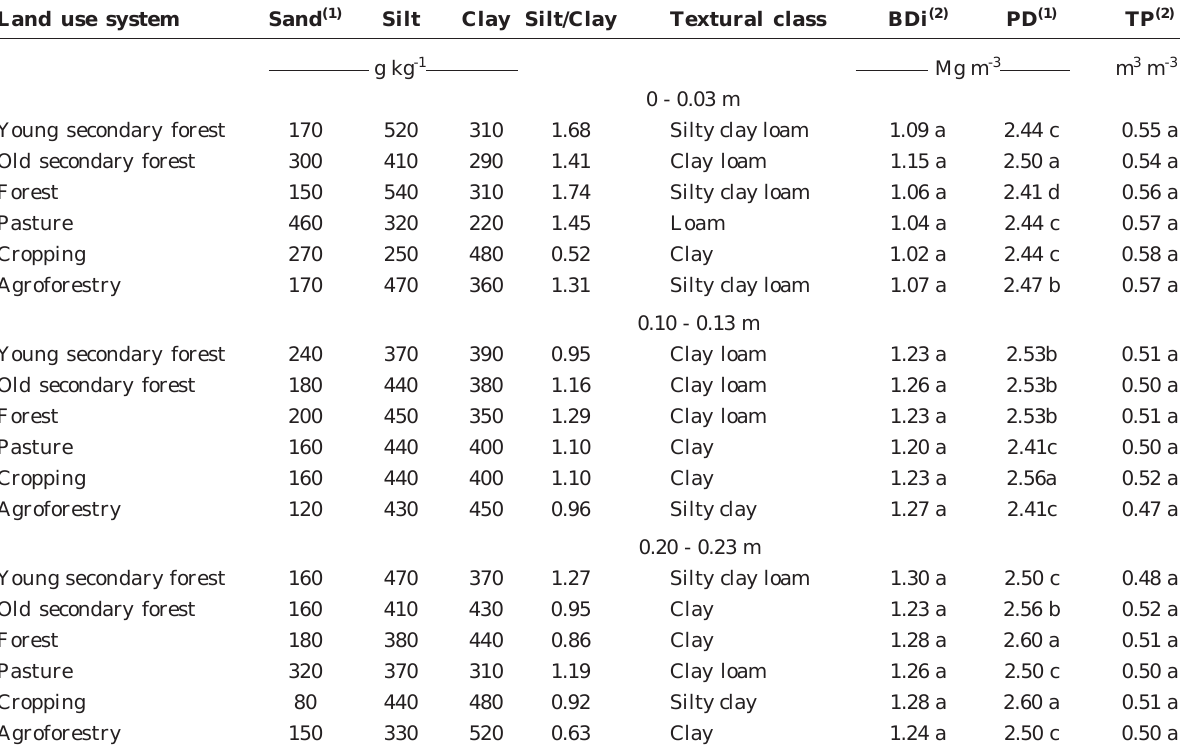
Table 1. Particle size distribution, silt/clay ratio, textural classes and physical characteristics of the Cambisol samples at three depths under different land use systems